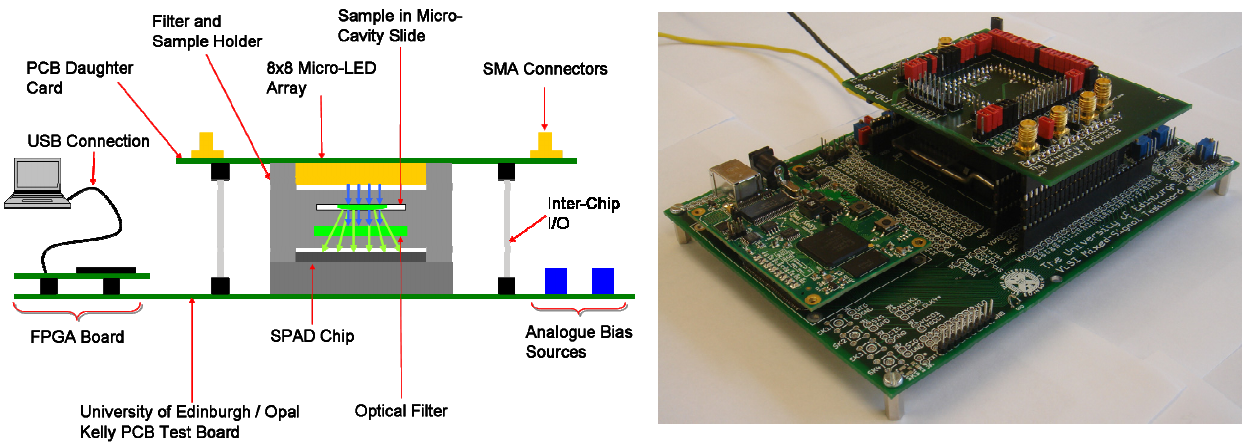
Figure 11. Complete two-chip micro-system. The PCB daughter card is physically supported by the filter and sample holder and stacked header pins.